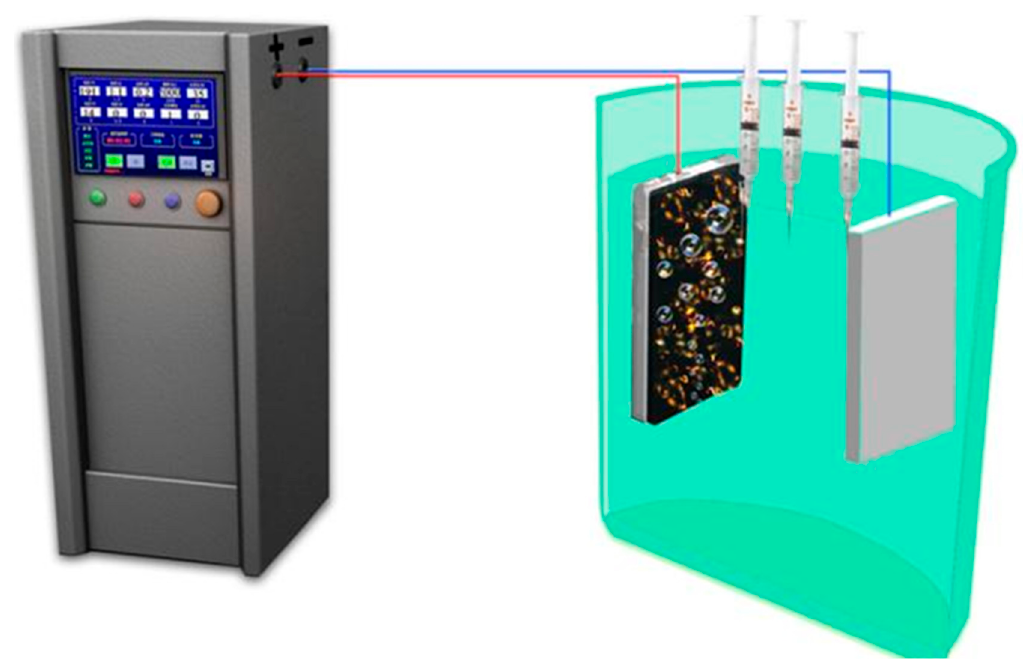
Figure 2. The schematic diagram of micro arc oxidation experiment.